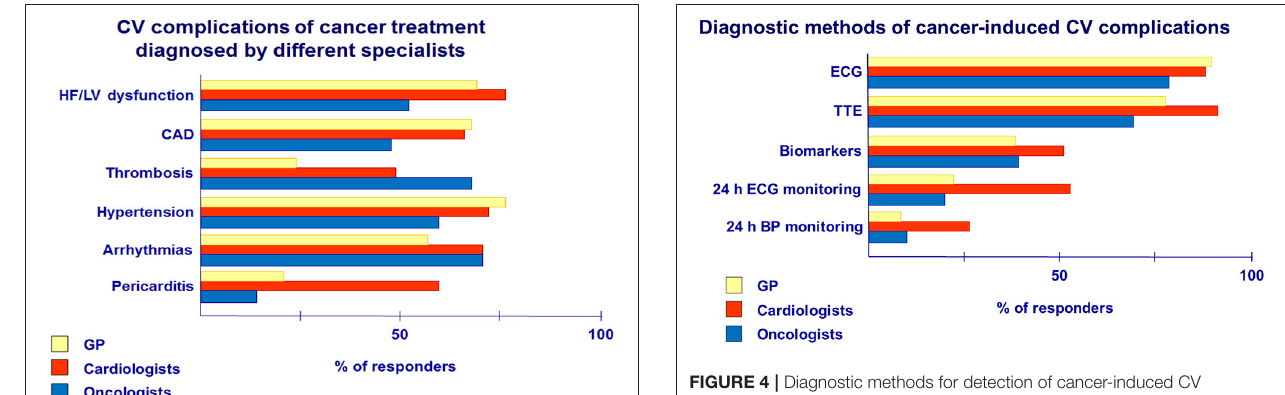
FIGURE 4 | Diagnostic methods for detection of cancer-induced CV